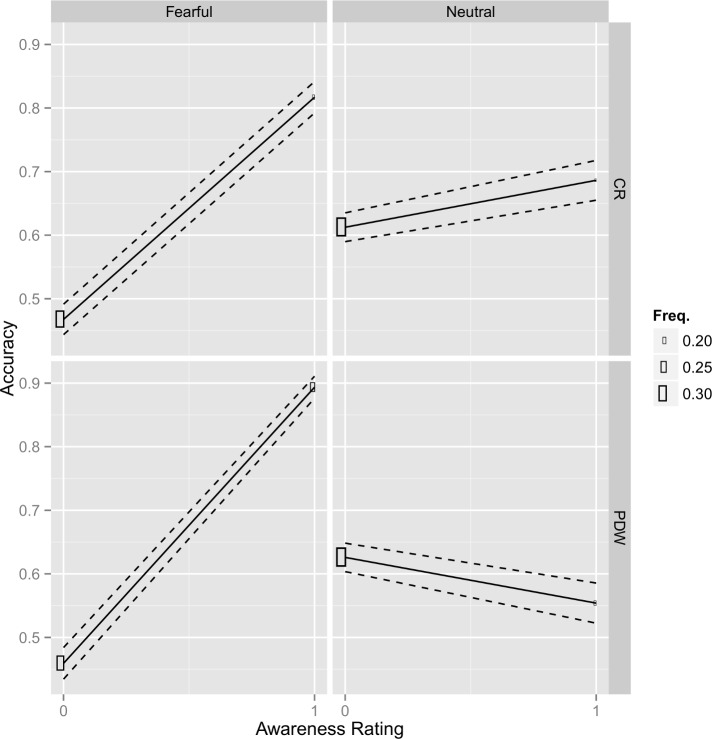
Average accuracy and scale response frequency for the relationship between accuracy and confidence ratings in each condition (CR—confidence ratings; PDW—post decision wagering) and each type of stimuli (F—fearful; N—neutral).Filled circles represent average accuracy for each scale point. The size of the scale points represents the frequency of responses (i.e. proportion of each confidence rating response in each condition).